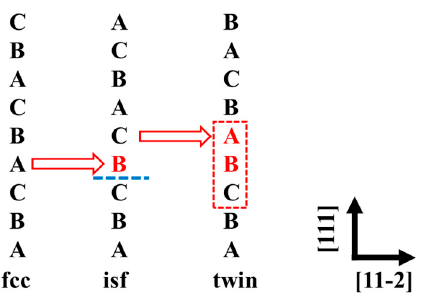
Figure 1. Schematic of planar fault path on {111} planes. Perfect face-cubic centered (fcc) bulk forms an intrinsic stacking fault by shearing one b p along <112> direction. Extrinsic stacking fault (twin) formed by shearing one b p along <112> direction in the adjacent layer of intrinsic stacking fault.